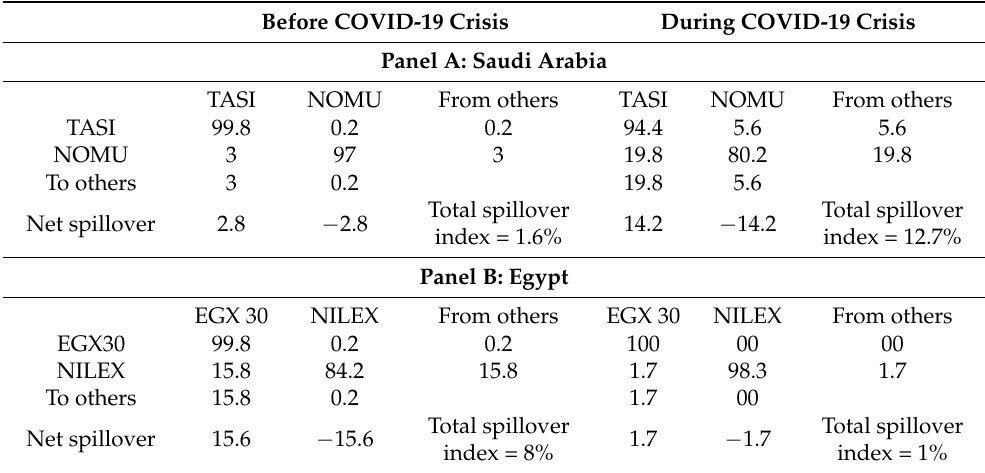
Table 3. Total and directional spillovers between the main and SME